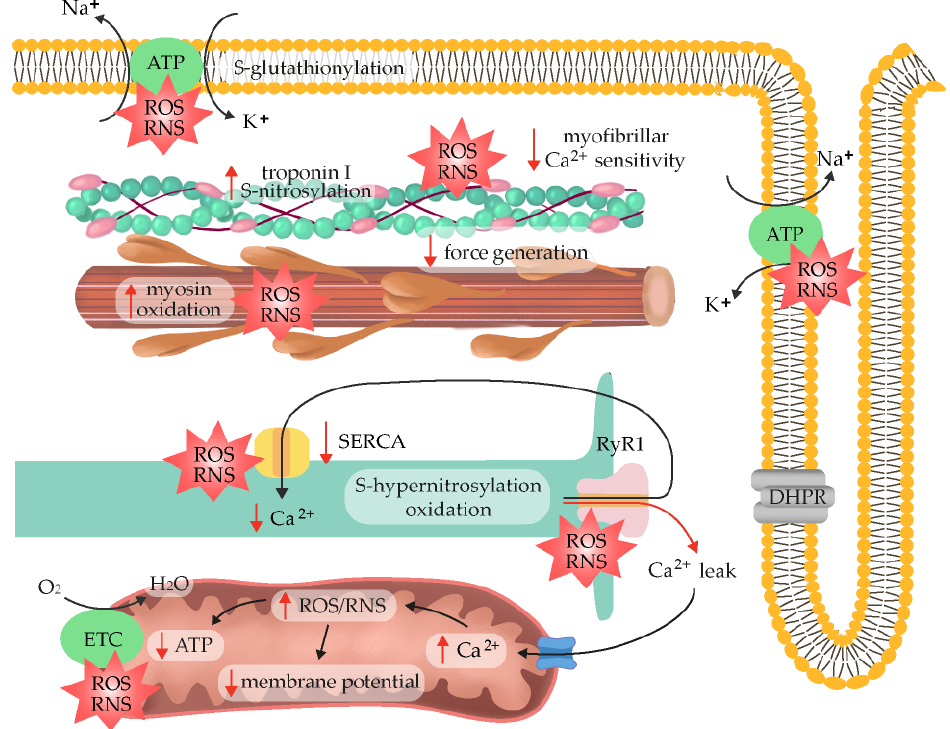
Figure 3. Mechanisms underlying muscle fatigue development in response to high intramuscular ROS/RNS concentration. Increased ROS/RNS levels can influence muscle force production through: ( 1) enhanced extracellular K + and reduced membrane excitability, ( 2) the oxidation/nitrosylation of RyR1 and sarco(endo) plasmic reticulum Ca 2+ ATPase (SERCA) to affect Ca 2+ release from the sarcoplasmic reticulum and clearance in skeletal muscle, ( 3) changes in Ca 2+ -sensitivity and cross-bridge kinetics, ( 4) mitochondrial Ca 2+ overload and mitochondrial ROS emission, and ( 5) lowered ATP production.